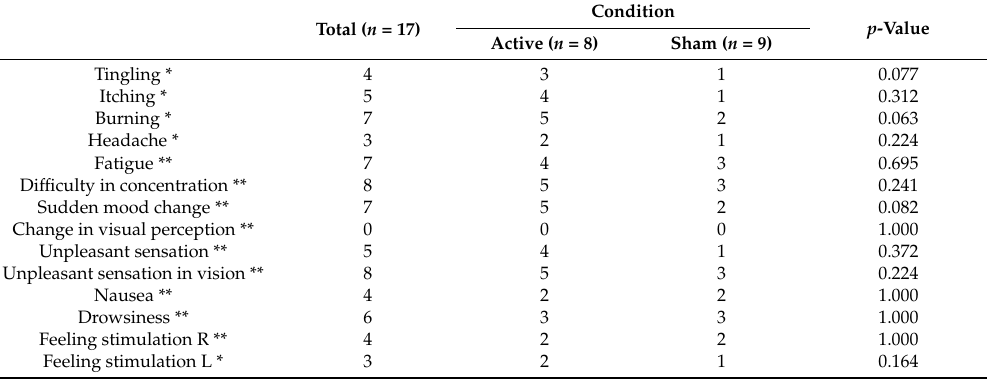
Table 1. Number of occurrences of side effects between active and sham groups for the cerebellum. Total ( n =